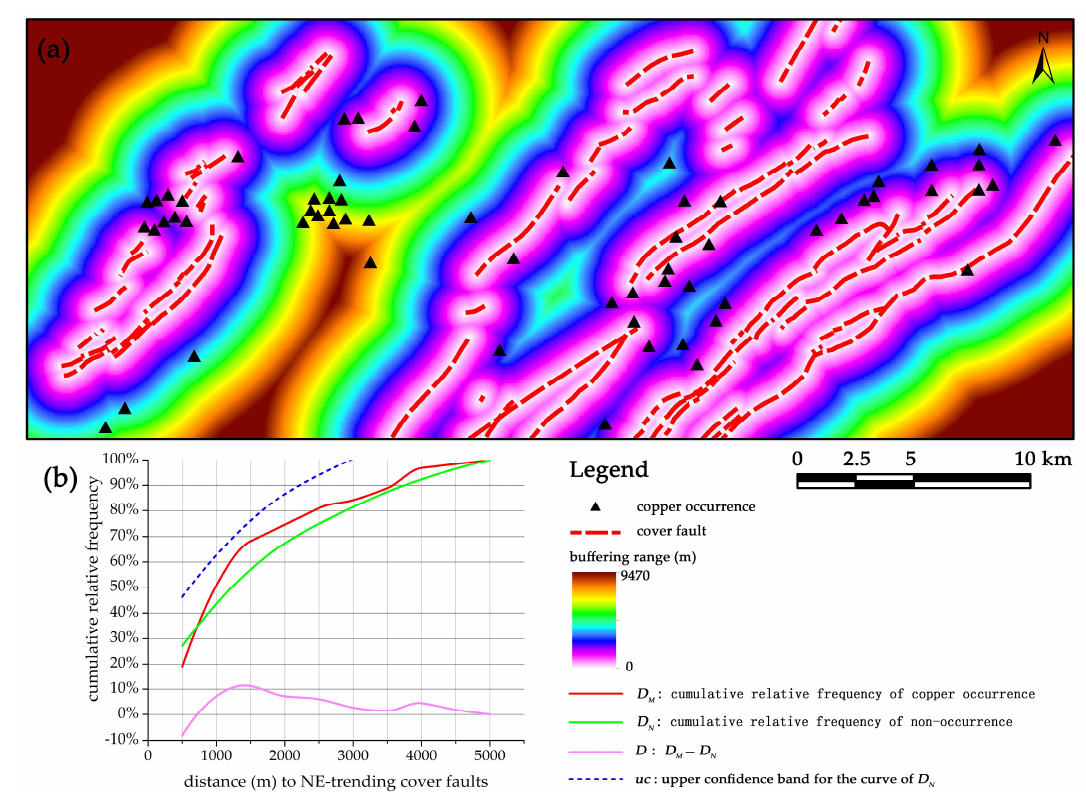
Figure 10. ( a ) Buffer analysis and ( b ) graph of cumulative relative frequency concerning distance to NE-trending faults.